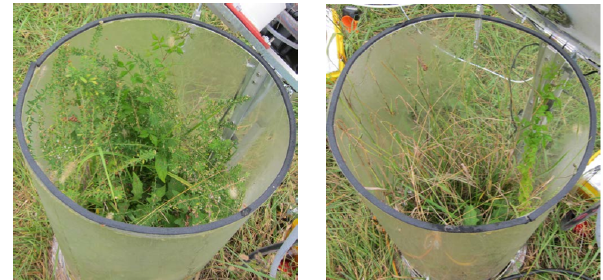
Figure 6. Chamber A (left). Chamber B (right). The vegetation in chamber A, prior to being moved on 24 September, was not repre- sentative of the typical vegetation type or LAI at the site. As a result, flux measurements prior to the move were large when compared with measurements from other chambers and eddy covariance. The vegetation in chamber B was representative of the vegetation in the